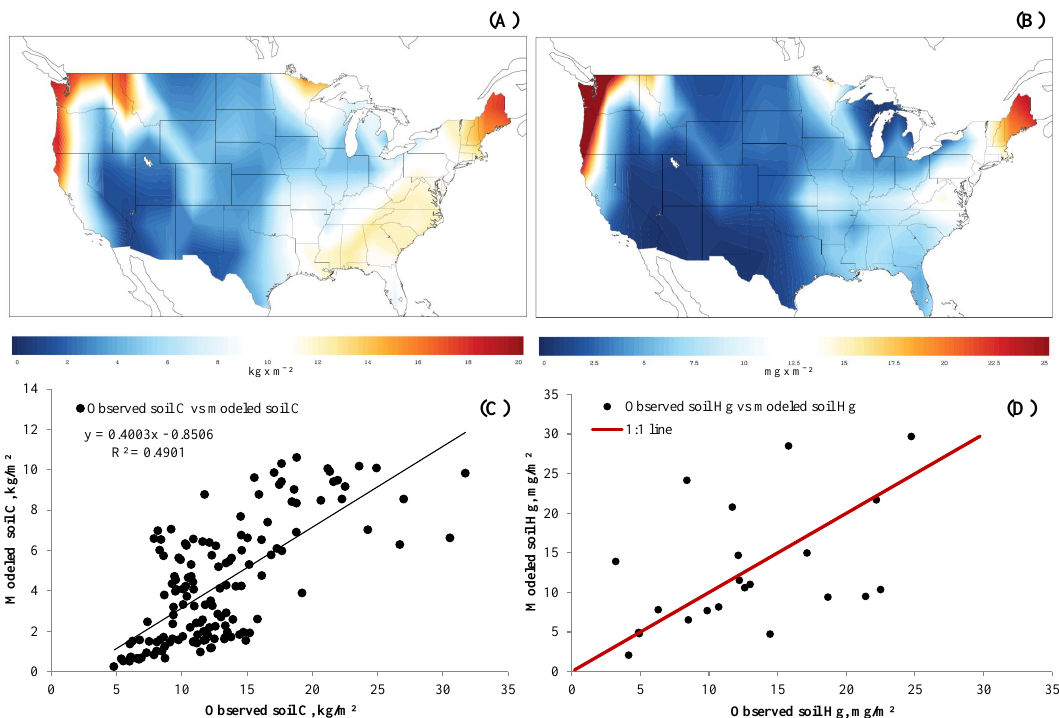
Fig. 2. Modelled present day carbon (A) and mercury (B) denities in the top 40cm of soils of the contiguous United States. Comparisons of modelled and observed data of soil C and Hg densities ( C and D